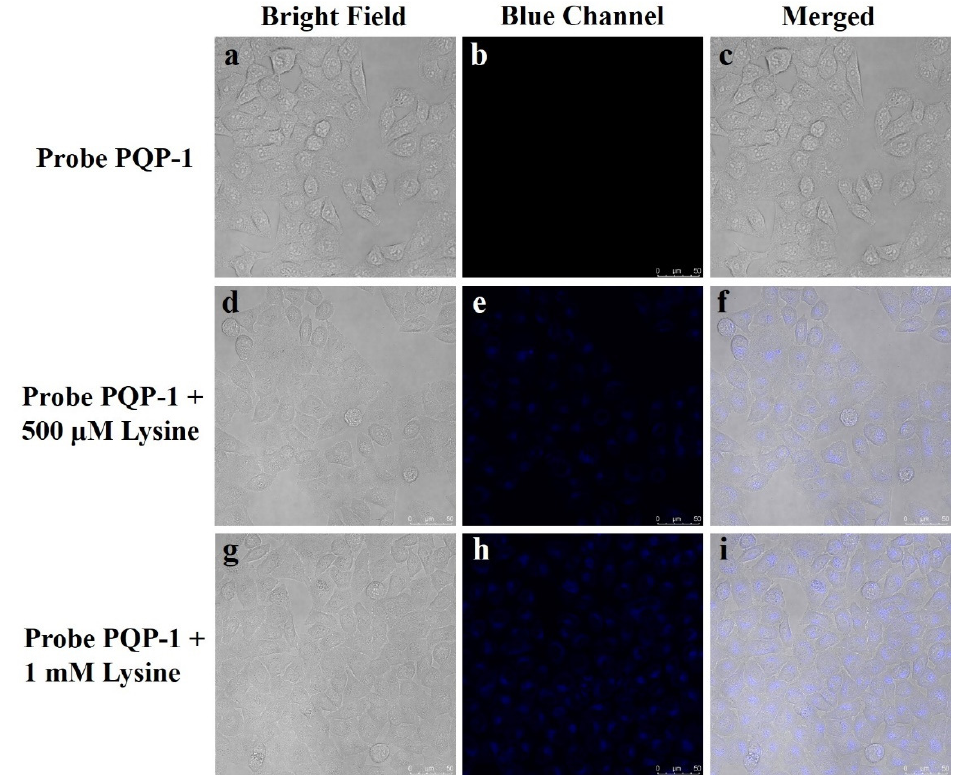
Figure 6. Fluorescence imaging of lysine in living HeLa cells. ( a – c ) images of HeLa cells treated with PQP ‐ 1 (10 μ M) for 30 min; ( d – f ) images of HeLa cells pretreated with PQP ‐ 1 (10 μ M) for 30 min, then incubated with 500 μ M L ‐ lysine for an additional 30 min; ( g – i ) images of HeLa cells pre ‐ incubated with PQP ‐ 1 (10 μ M) for 30 min, then treated with 1 mM L ‐ lysine for an additional 30 min. Excitation at 405 nm; Scale bar: 50 μ m.